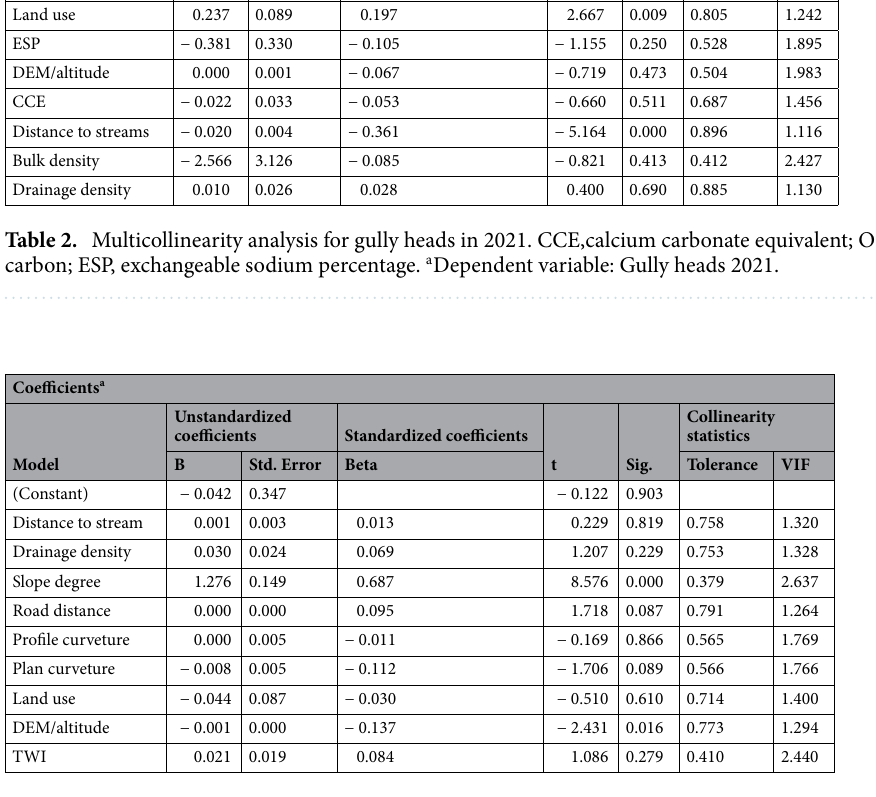
Table 3. Multicollinearity analysis for Landslides in 2021. TWI, topographic wetness index. a Dependent variable: Landslides